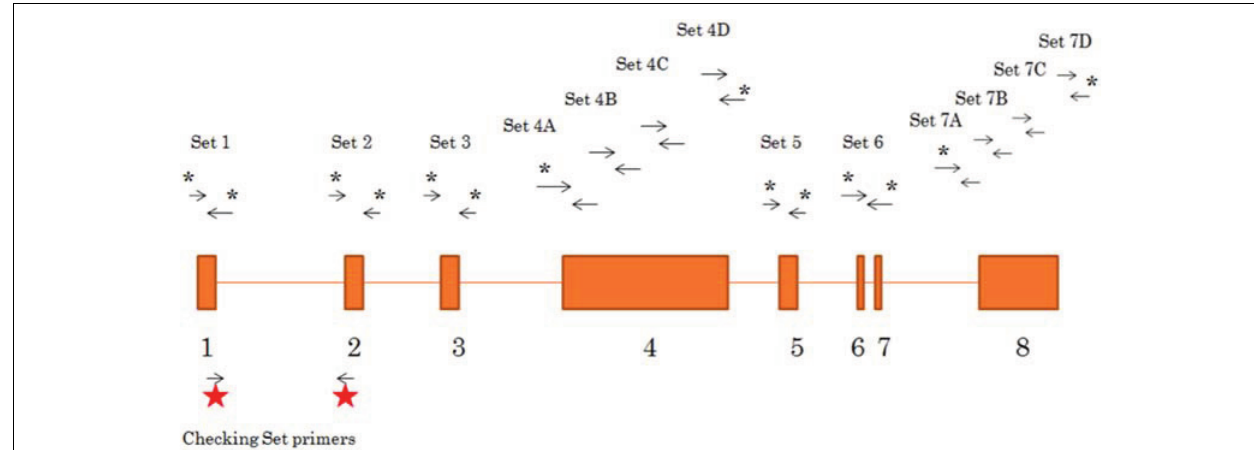
FIGURE 1 | Schematic representation of primers sets used to amplify the LATS1 gene. 13 sets of primers were designed (sequence details shown in Supplemental Table 1) to amplify and sequence LATS1 . Primer sets with an asterisk are the sets used for